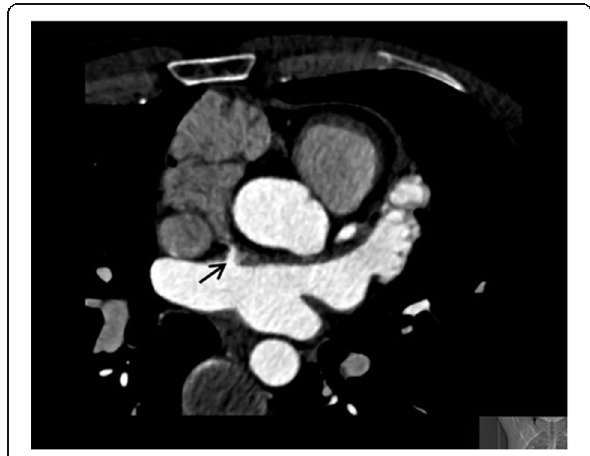
Fig. 3 Gated CT angiogram shows a small defect in the upper part